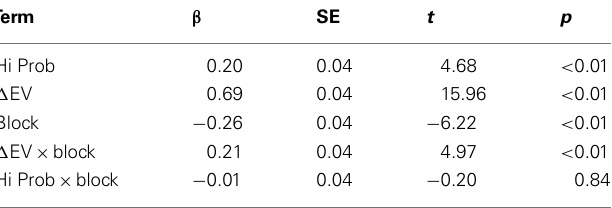
Table 2 | Multiple regression of standardized, logit-transformed proportion of high probability choices among k j,young,t ≤ 40 younger adults on 96 independent trials with one RA-related predictor (the probability of the high probability option, Hi Prob), one EV-related predictor (the difference in EVs: Δ EV), and a dummy variable for block.